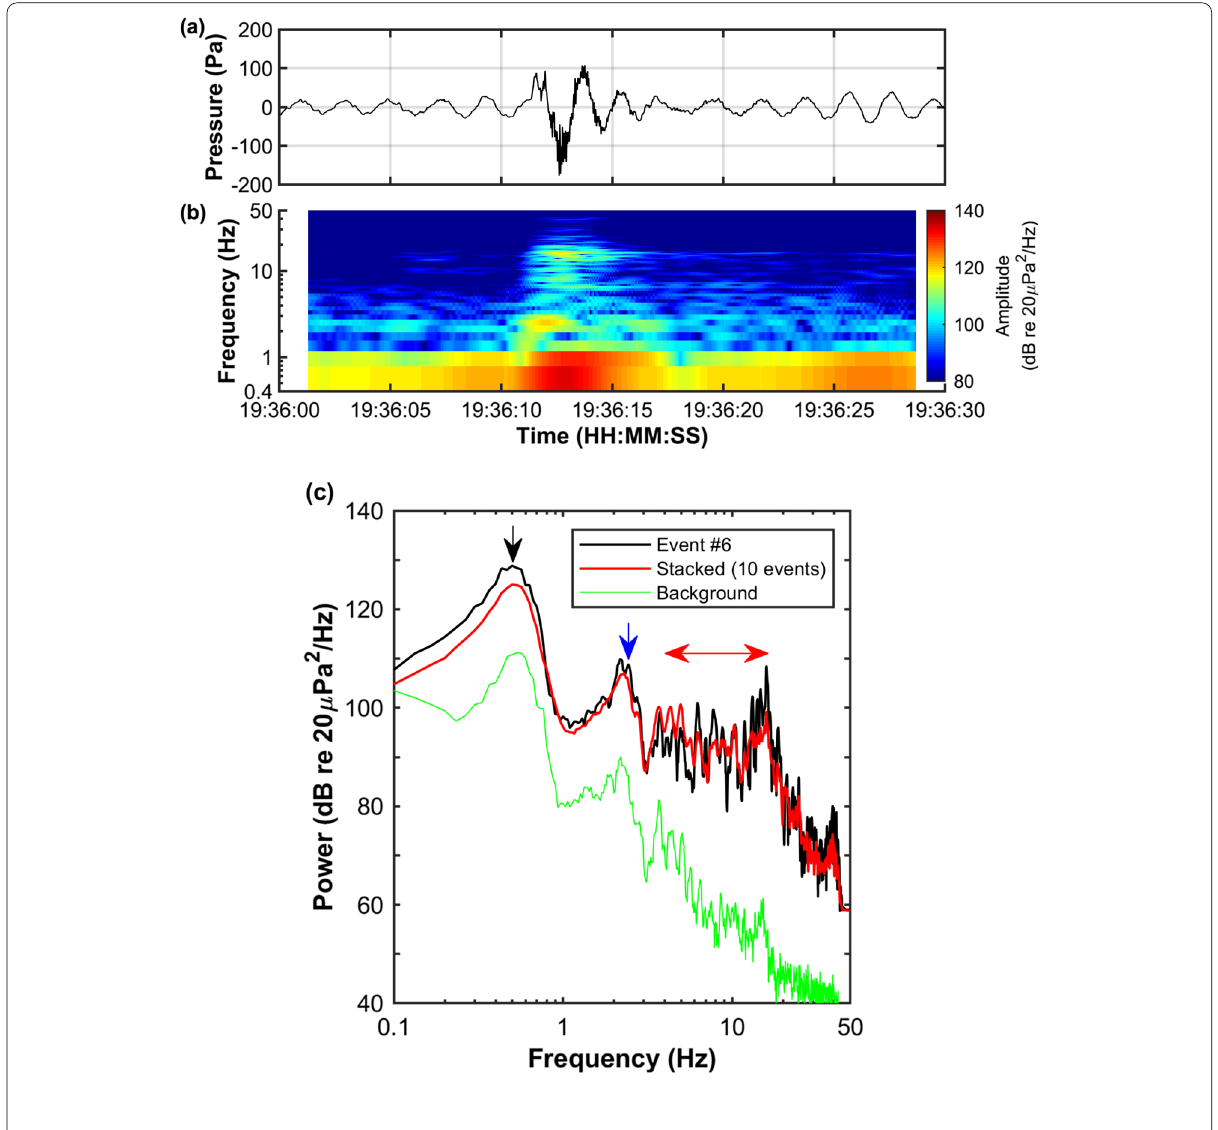
Fig. 17 Infrasound observed at the Aso volcano, Japan, on April 21, 2015 (JST) (Ishii et al. 2019). a An example of a waveform (detrended). b Spectrogram of ( a ) (time window 2.56 s, overlap 2.50 s). c Power spectrum (smoothed) of ( a ) (event#6), stacked spectrum of 10 events